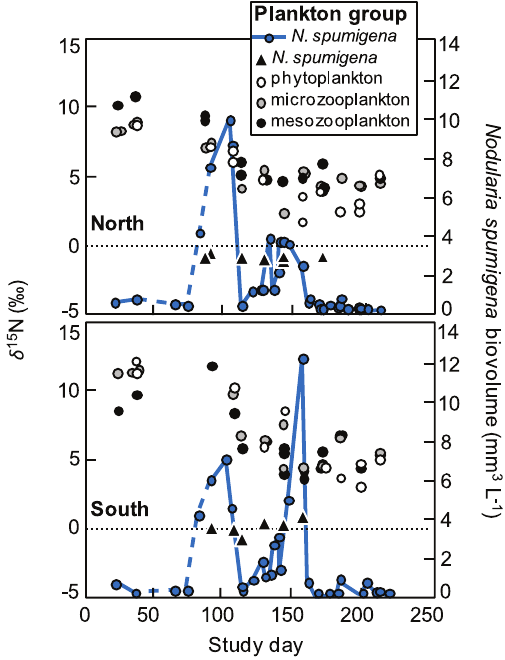
Figure 1. Time series of plankton and Nodulariaspumigena d 15 N isotope composition and N.spumigena biovolumes. Time series of size-fractioned plankton and N. spumigena d 15 N isotope ( % ) values, and N. spumigena biovolumes (mm 3 L 2 1 ; blue line with circles) collected at a north (upper panel; N isotope =52, N biovolume =30) and south (lower panel; N isotope =48, N biovolume =31) sampling site in Lake King, Australia. Dashed sections of blue lines show N. spumigena biovolumes averaged across several locations (study days 69 and 76: n =3 locations; study day 84: n =7 locations) proximal to the Lake King north (upper panel) and south (lower panel) sampling sites (values represent best estimates of local biovolumes during this interval). The x-axis shows the number of days elapsed since 1 September 2011 (study day=1).